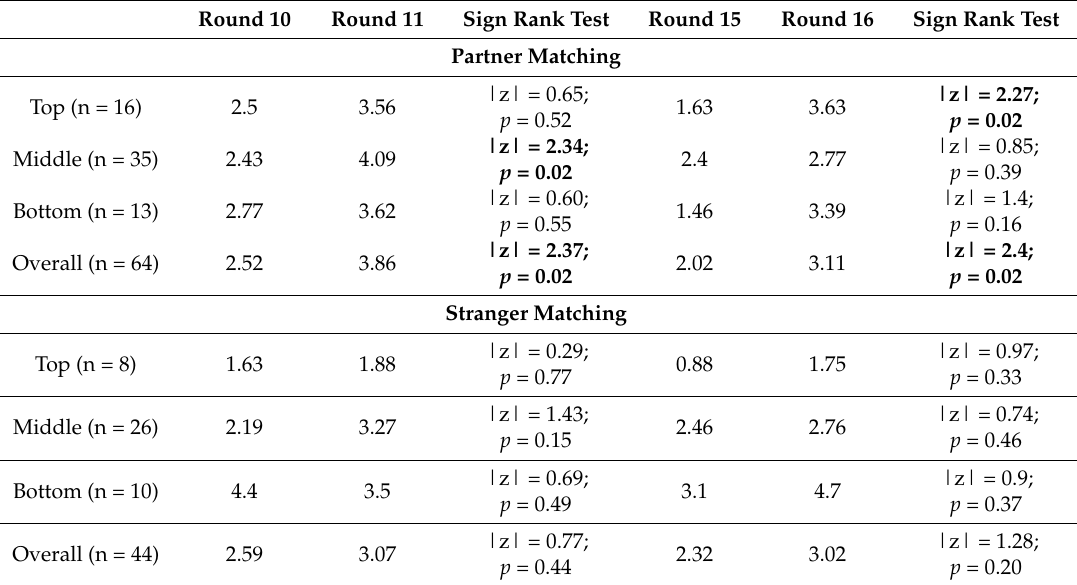
Table 7. Contributions following restart, by